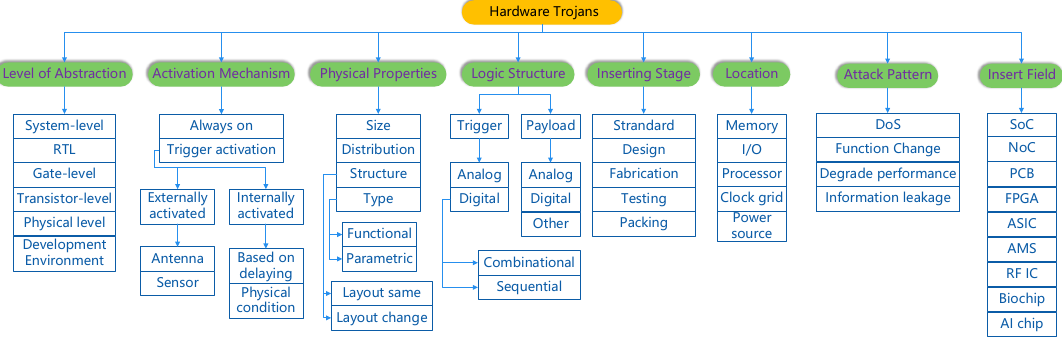
Figure 10. Comprehensive classifications of